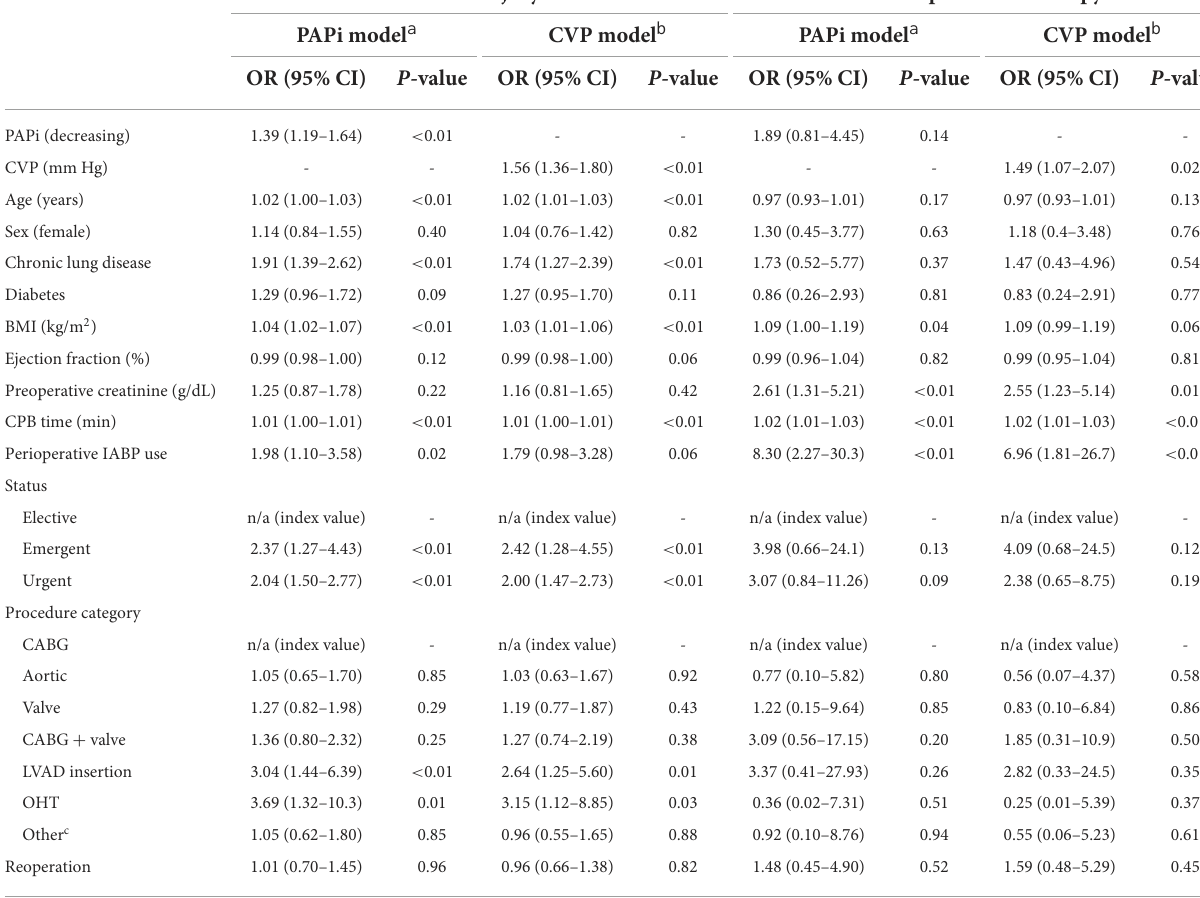
TABLE 3 Multivariable logistic regression analyses for renal injury and renal replacement therapy in association with postoperative pulmonary artery pulsatility index (PAPi) and central venous pressure (CVP)